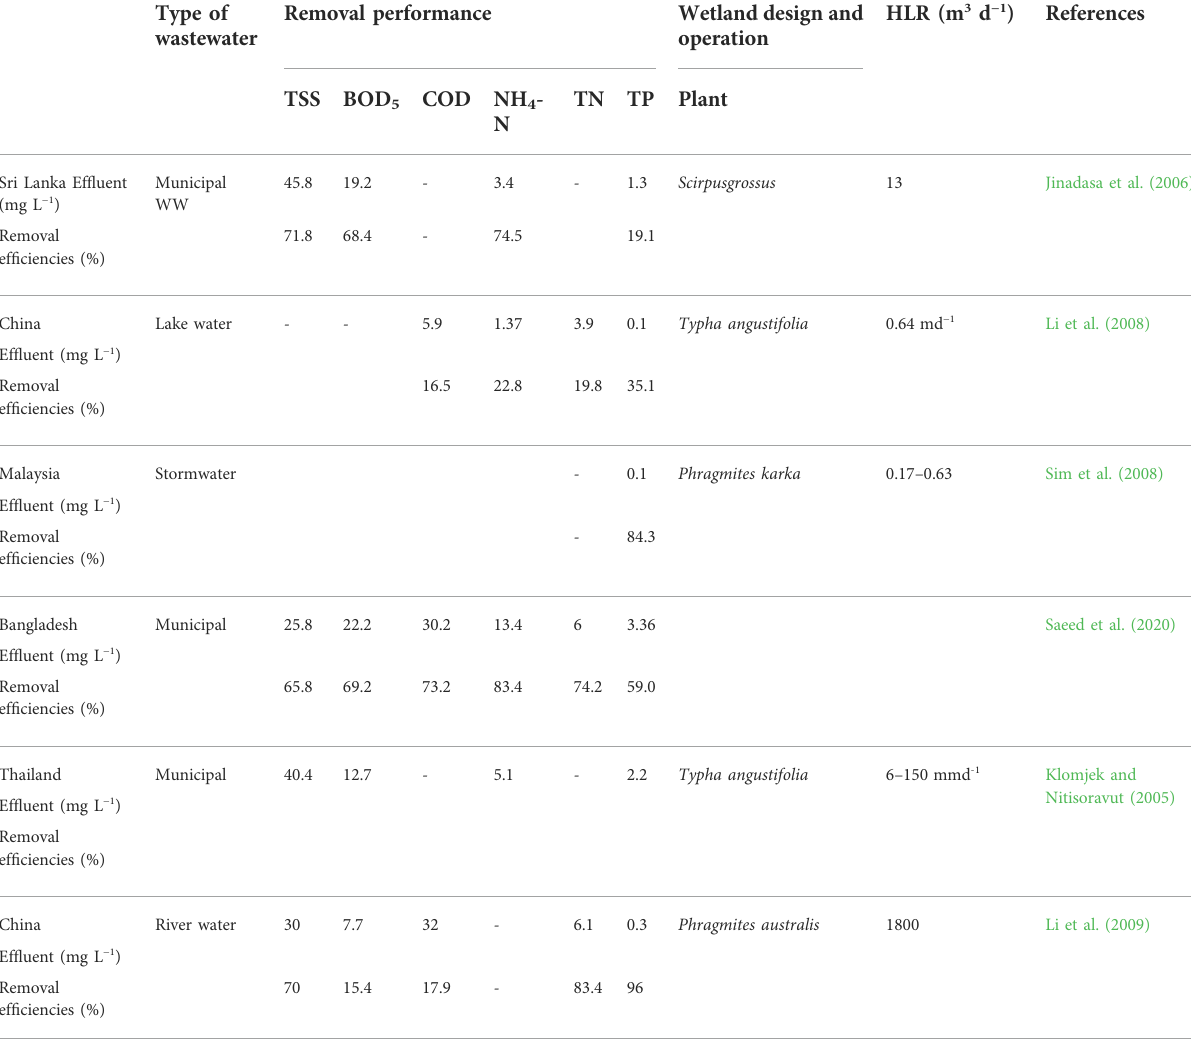
TABLE 1 An overview of the FWS systems ’ operating characteristics and treatment performance in Asian